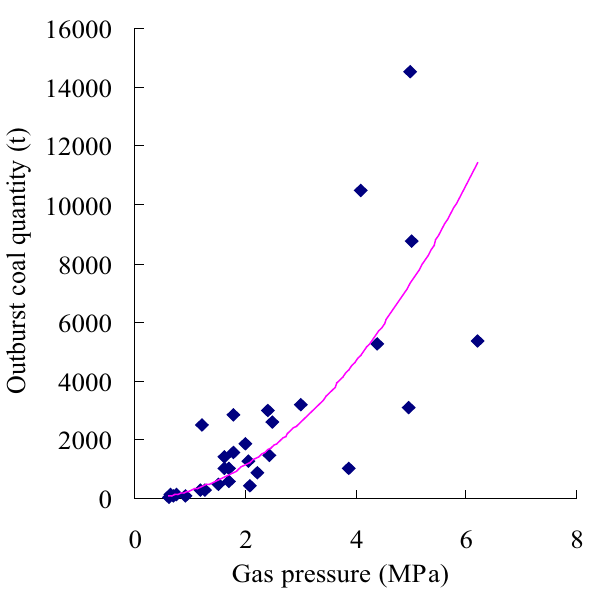
Figure 5. Relationship between the outburst coal quantity and coal seam gas